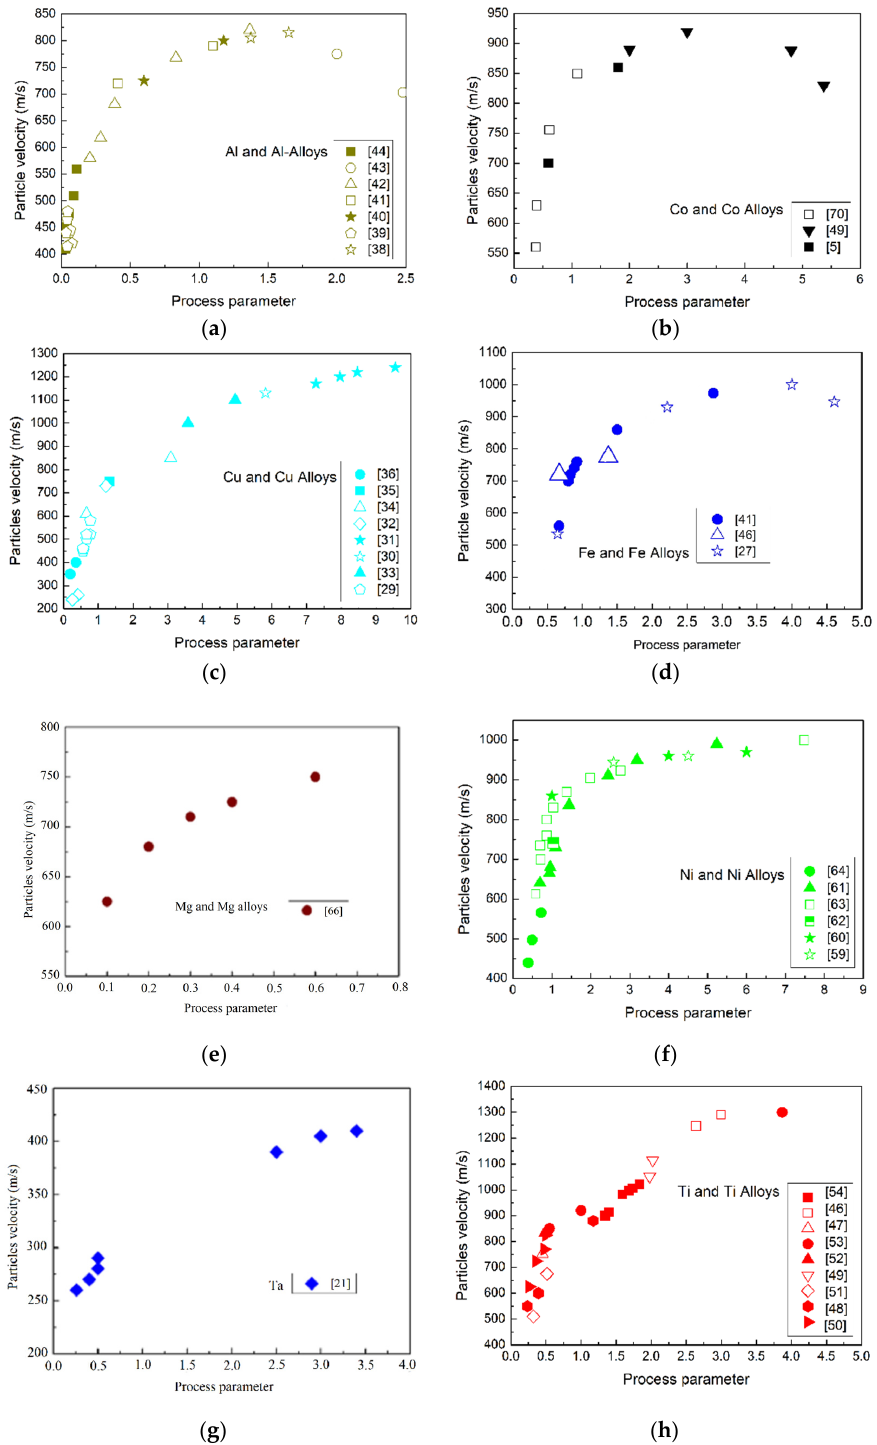
Figure 3. Particle velocity vs. process parameter for the different pure metals and alloys analyzed in the present study. ( a ) Al and Al Alloys [38–44], ( b ) Co and Co Alloys [5,49,70], ( c ) Cu and Cu Alloys [29–36], ( d ) Fe and Fe Alloys [27,41,46], ( e ) Mg and Mg Alloys [66], ( f ) Ni and Ni Alloys [59–64], ( g ) Ta [21], (h) Ti and Ti Alloys [46–54].